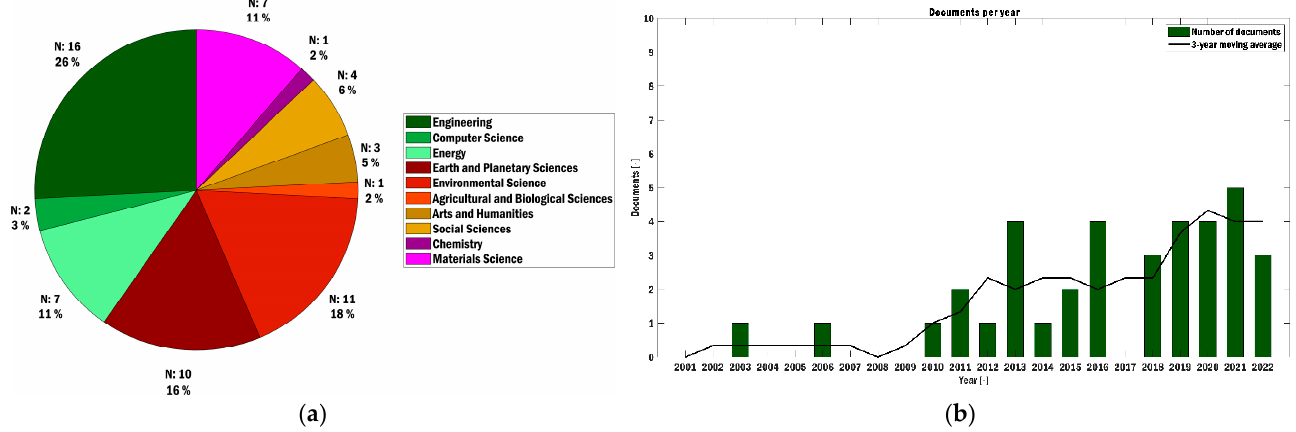
Figure 2. Document type distribution.